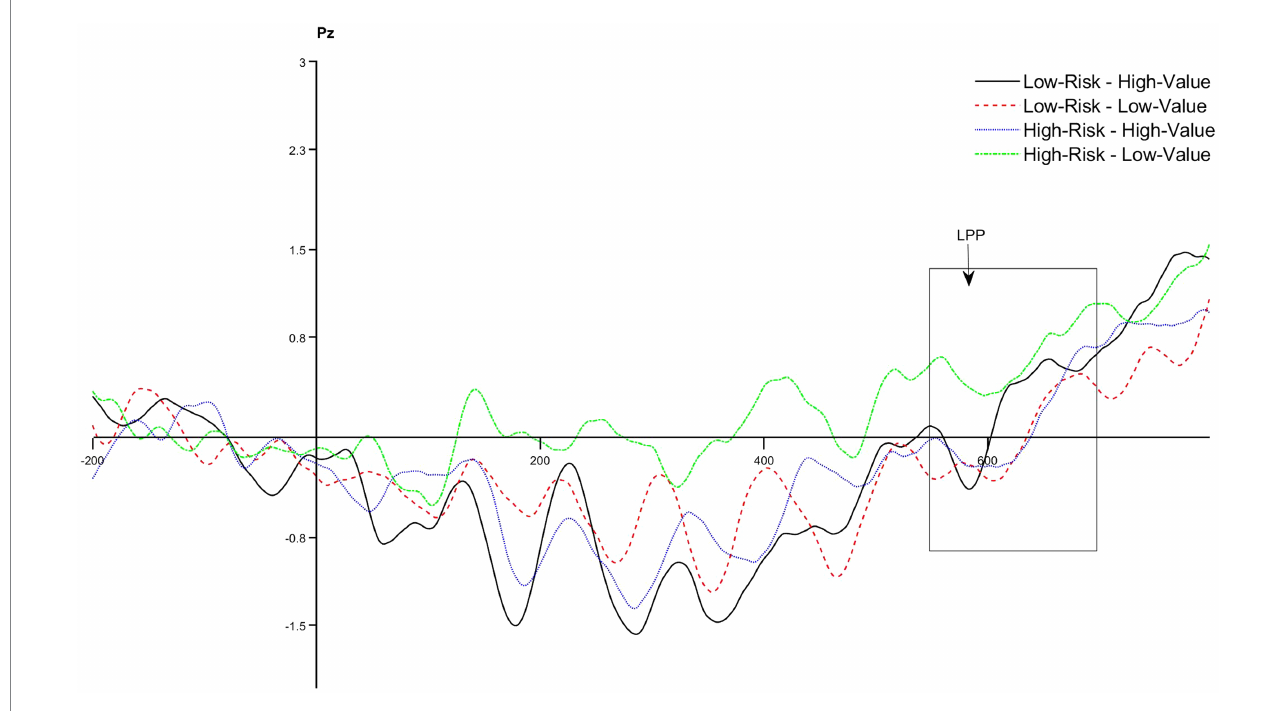
FIGURE 4 The amplitude of LPP